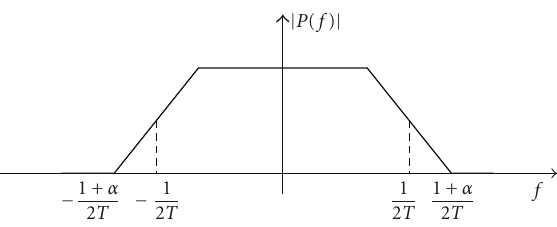
Figure 1: Magnitude response of a Nyquist filter with an excess bandwidth of α/T . Note that P ( f ) has the total banwidth (1 + α ) / 2 T − ( − (1 + α ) / 2 T ) = (1 + α ) /T , and the minimum bandwidth